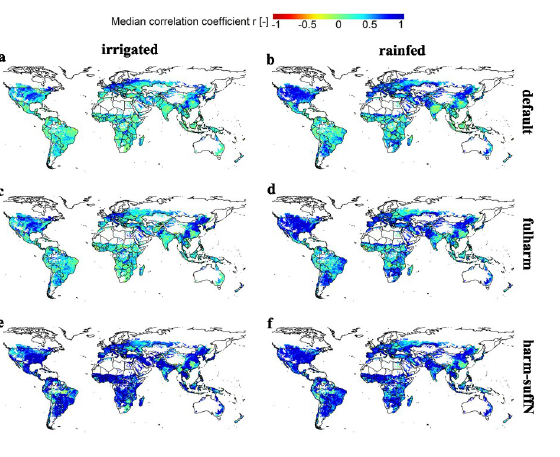
Fig 4. Median time-series correlation coefficient r for maize yield estimates among EPIC-based GGCMs. Panels reflect each of the six crop management scenarios defined in Table 1. Complementary maps without EPIC-TAMU, for which default and fullharm are identical, are provided in Fig K in S1